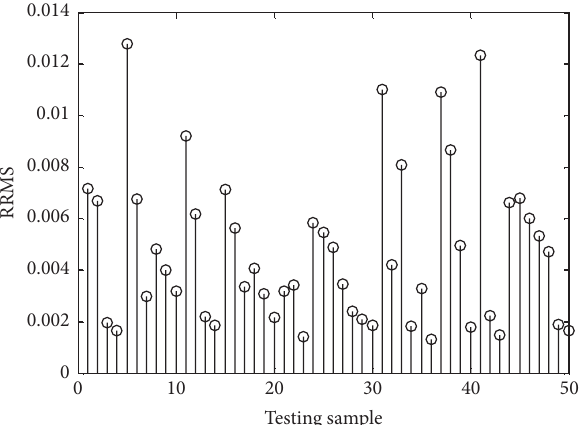
Figure 5: Spectral reflectance error of the 50 halftone